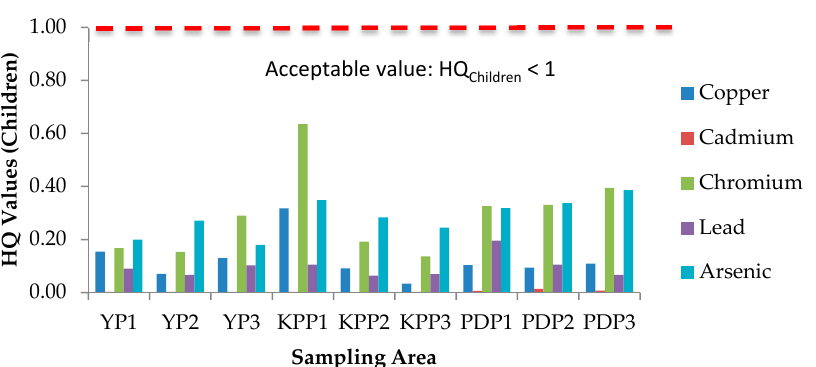
Figure 7. Hazard Quotient (HQ) values for children in three plots of Yan, Kubang Pasu, and Pendang. YP1: Yan Plot 1, YP2: Yan Plot 2, YP3: Yan Plot 3, KPP1: Kubang Pasu Plot 1, KPP2: Kubang Pasu Plot 2, KPP3: Kubang Pasu Plot 3, PDP1: Pendang Plot 1, PDP2: Pendang Plot 2, and PDP3: Pendang Plot 3.